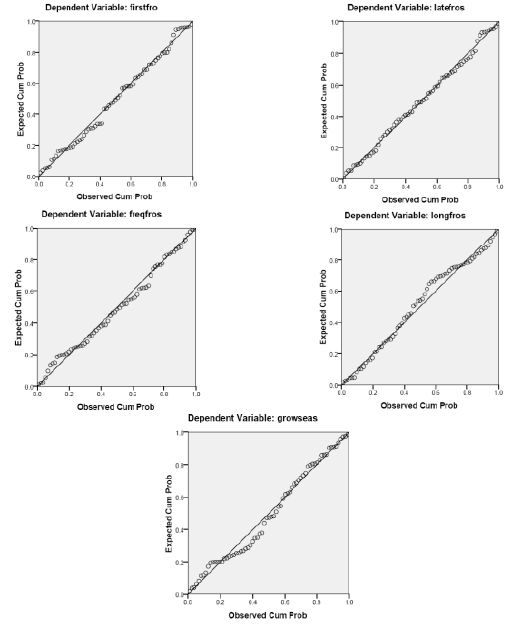
Figure 5: P-P Plots in order to test the normality of errors for